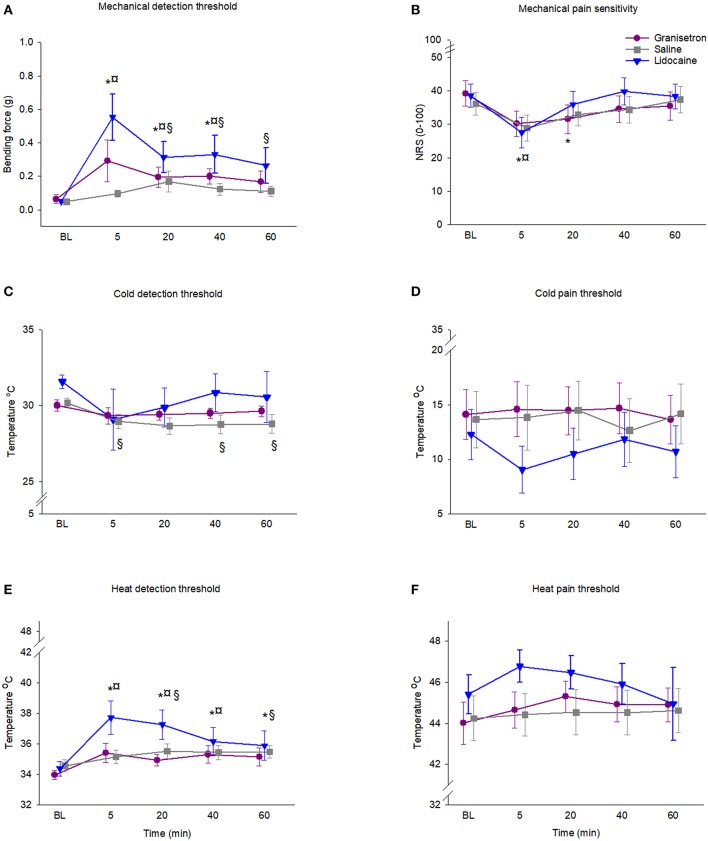
Graph showing the changes in skin sensitivity after subcutaneous injection of granisetron (test substance), lidocaine (positive control), or saline (negative control) into the skin overlying the masseter muscle in 18 healthy males. (A) Mechanical detection threshold (MDT), (B) mechanical pain sensitivity (MPS), (C) heat detection threshold (HDT), (D) heat pain threshold (HPT), (E) cold detection threshold (CDT), and (F) cold pain threshold (CPT). Mean (SEM) values are presented. In order to clarify, the time points for each substance are differentiated. The special characters indicate significant differences compared to baseline (p < 0.05) for *granisetron, ¤lidocaine, and §saline.